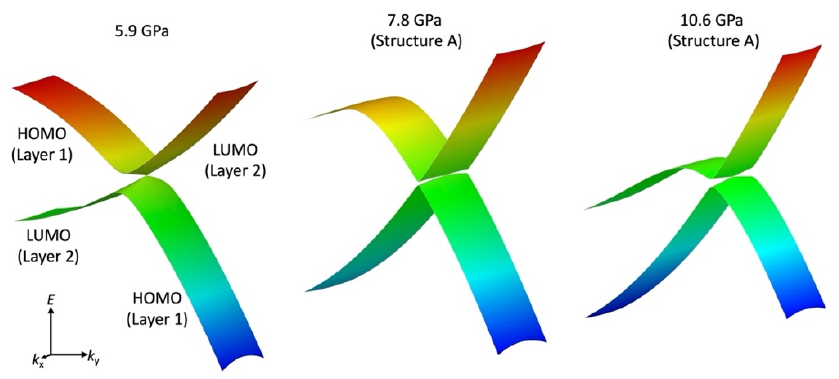
Figure 6. Dirac cone at k z = 0 in [Pd(dddt) 2 ] at 5.9 GPa, 7.8 GPa and 10.6 GPa.